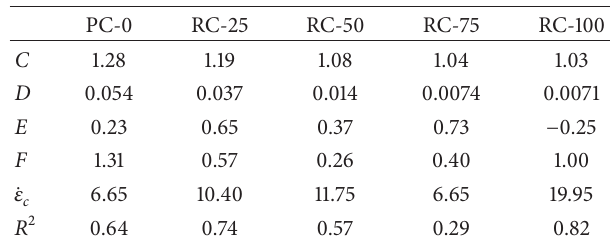
Table 2: Parameters in (1) for RAC specimens. Table 3: Parameters in (3) for RAC